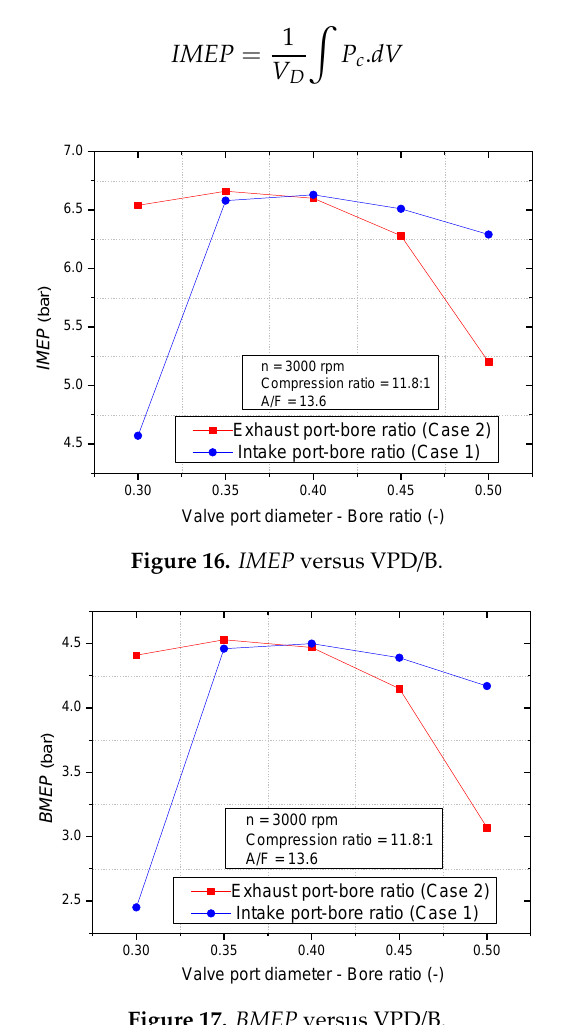
Figure 18. BSFC versus VPD/B. The opposite trends of BMEP and BSFC are depicted in Figures 17 and 18. The minimum BSFC is 849.5 g/kWh in Case 1 and 842.8 g/kWh in Case 2. It can be seen that, at the intake, the port-bore ratio is smaller than 0.35 or exhaust port-bore ratio is bigger than 0. 45. The missing firing may happen because of this band of VPD/B ratio, the BSFC value and HC emission were very high and NO x emission was nearly zero. If the intake port-bore ratio is smaller than 0.35 or the exhaust port-bore ratio is bigger than 0. 45, it is not a good condition for the engine to operate. The similar trend between BMEP and engine effective torque can be observed through Figures 17 and 19. The effect of BMEP on engine effective torque is presented in Equation (13). Equation (13) shows that a higher BMEP due to an enhanced engine torque. . . D eff